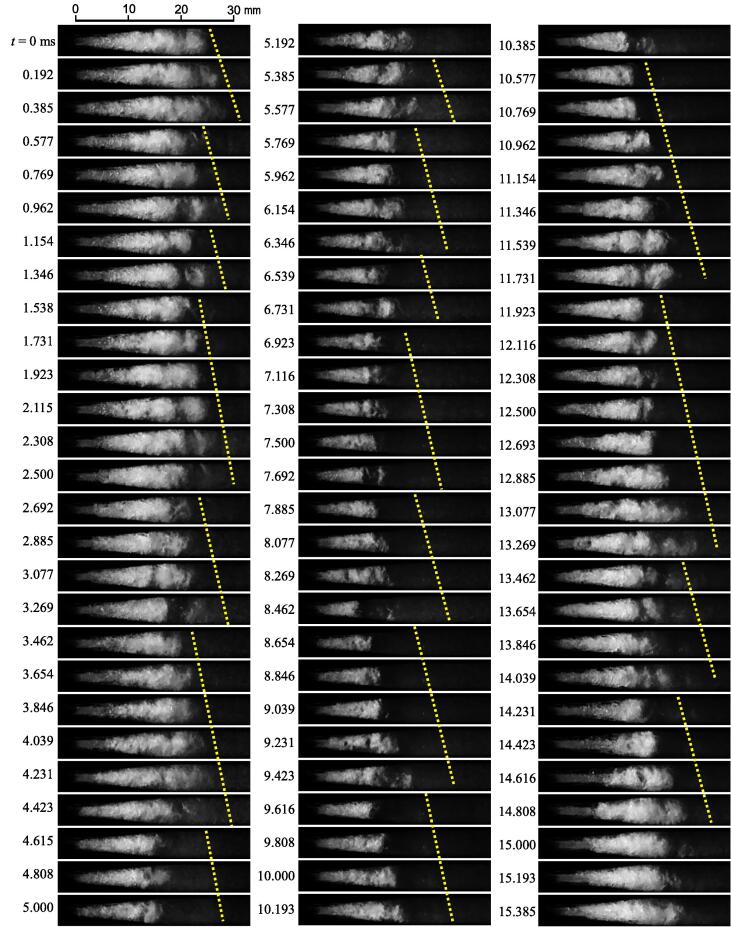
Unsteady behavior of vortex cavitation (p1 = 0.6 MPa, p2 = 0.1 MPa, t = 0 – 15.385 ms).